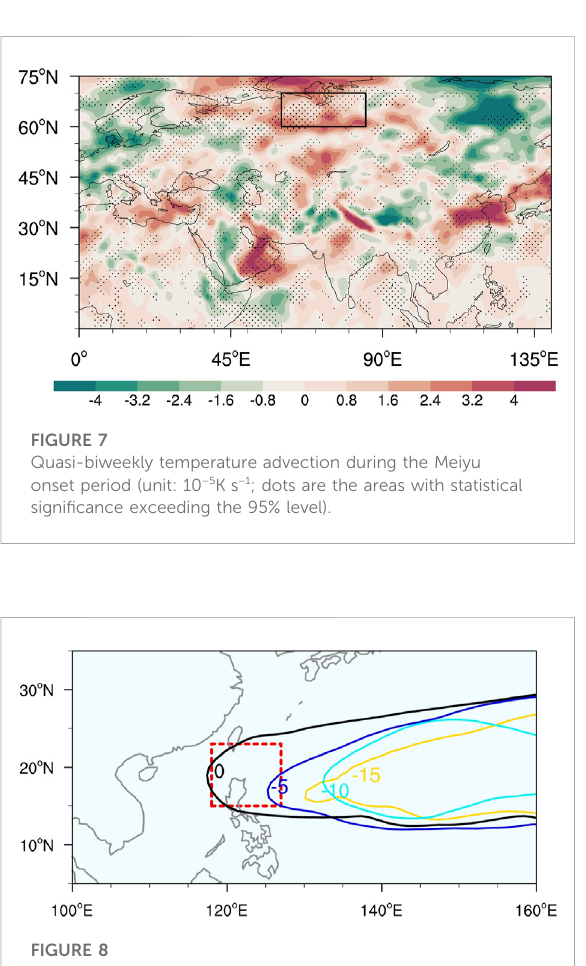
FIGURE 8 Distributions of 588 dagpm isograms from lead 15 d to the onset day (red box: the low-latitude key region (15 ° N-23 ° N,118 ° E- 127 ° E); unit: dagpm;black counter, onset day; purplecounter, lead 5 d; blue counter, lead 10 d; yellow counter, lead 15